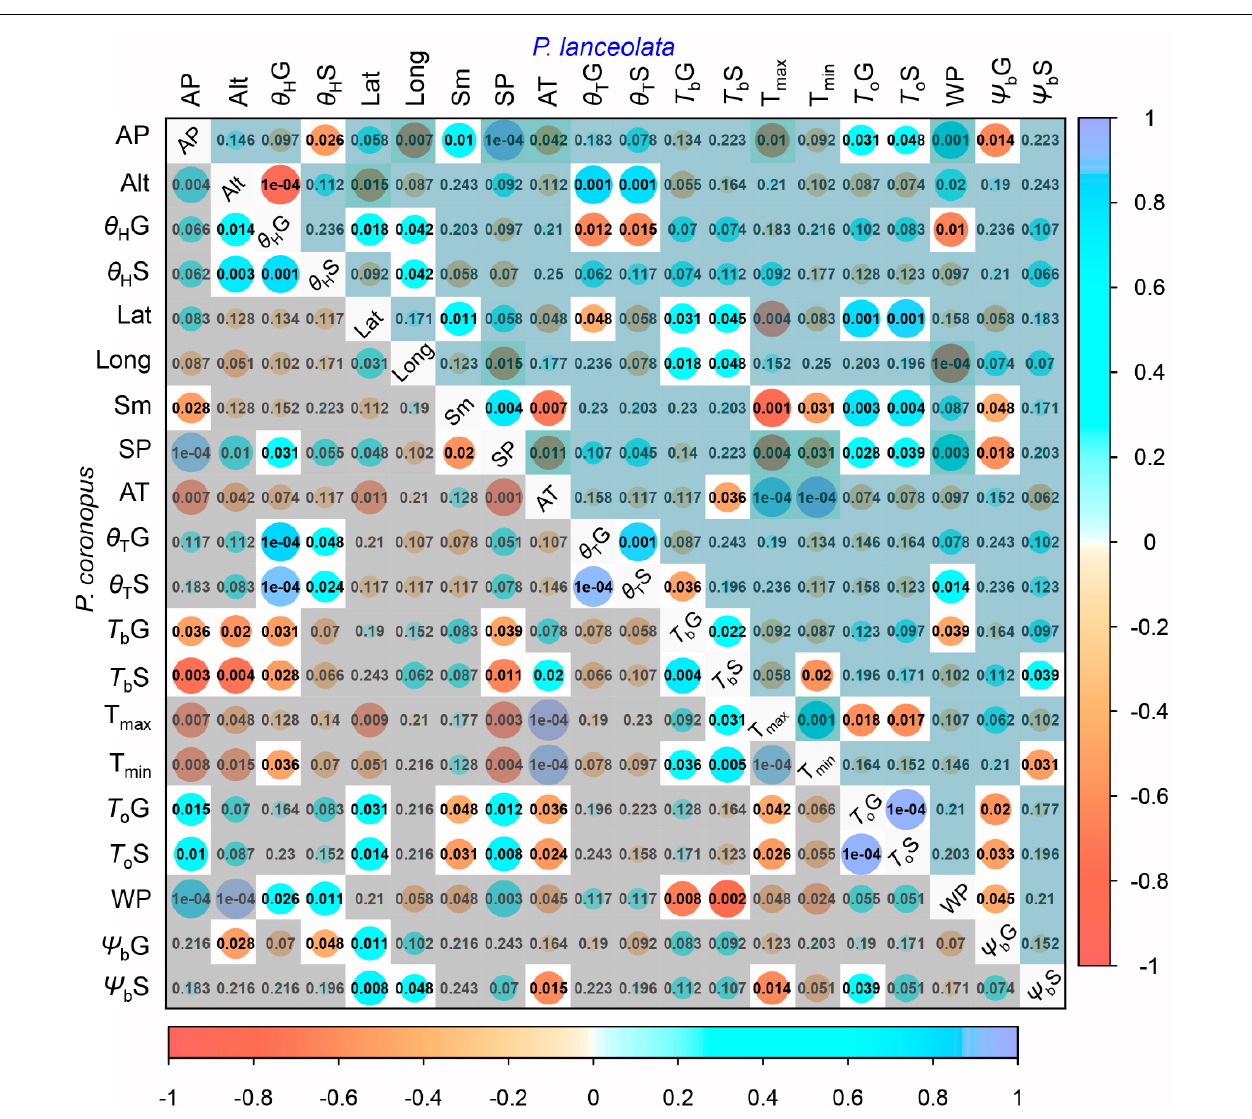
FIGURE 4 | Spearman’s correlation rank diagonal matrix of the geographical, climatic, and experimental data variables ( Supplementary Tables S1, S2 ) for P. coronopus (lower) and P. lanceolata (upper). Each matrix displays the color-coded correlation coefficients ( rho ) explained by the lateral and bottom color key. The circle sizes represent the rho values with the exact p -values, shaded if P > 0.05 or if not correlated with physiological